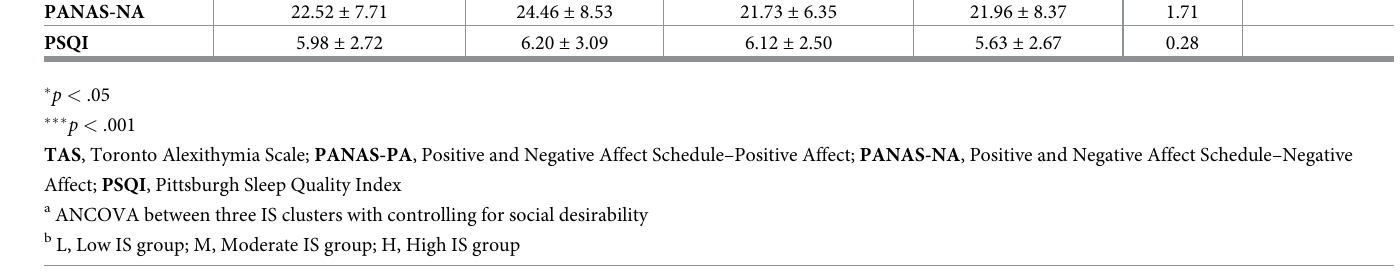
The regression coefficients of the three IS clusters are given in Table 4. After controlling for social desirability, higher TAS scores were significantly predictive of higher PSQI ( β = 0.36, p = .010) in the low IS cluster, while PA and NA scores were selected out. In contrast, higher NA scores were significantly predictive of higher PSQI in the moderate ( β = 0.26, p = .011) and high ( β = 0.35, p = .004) IS clusters, while TAS and PA scores were selected out.